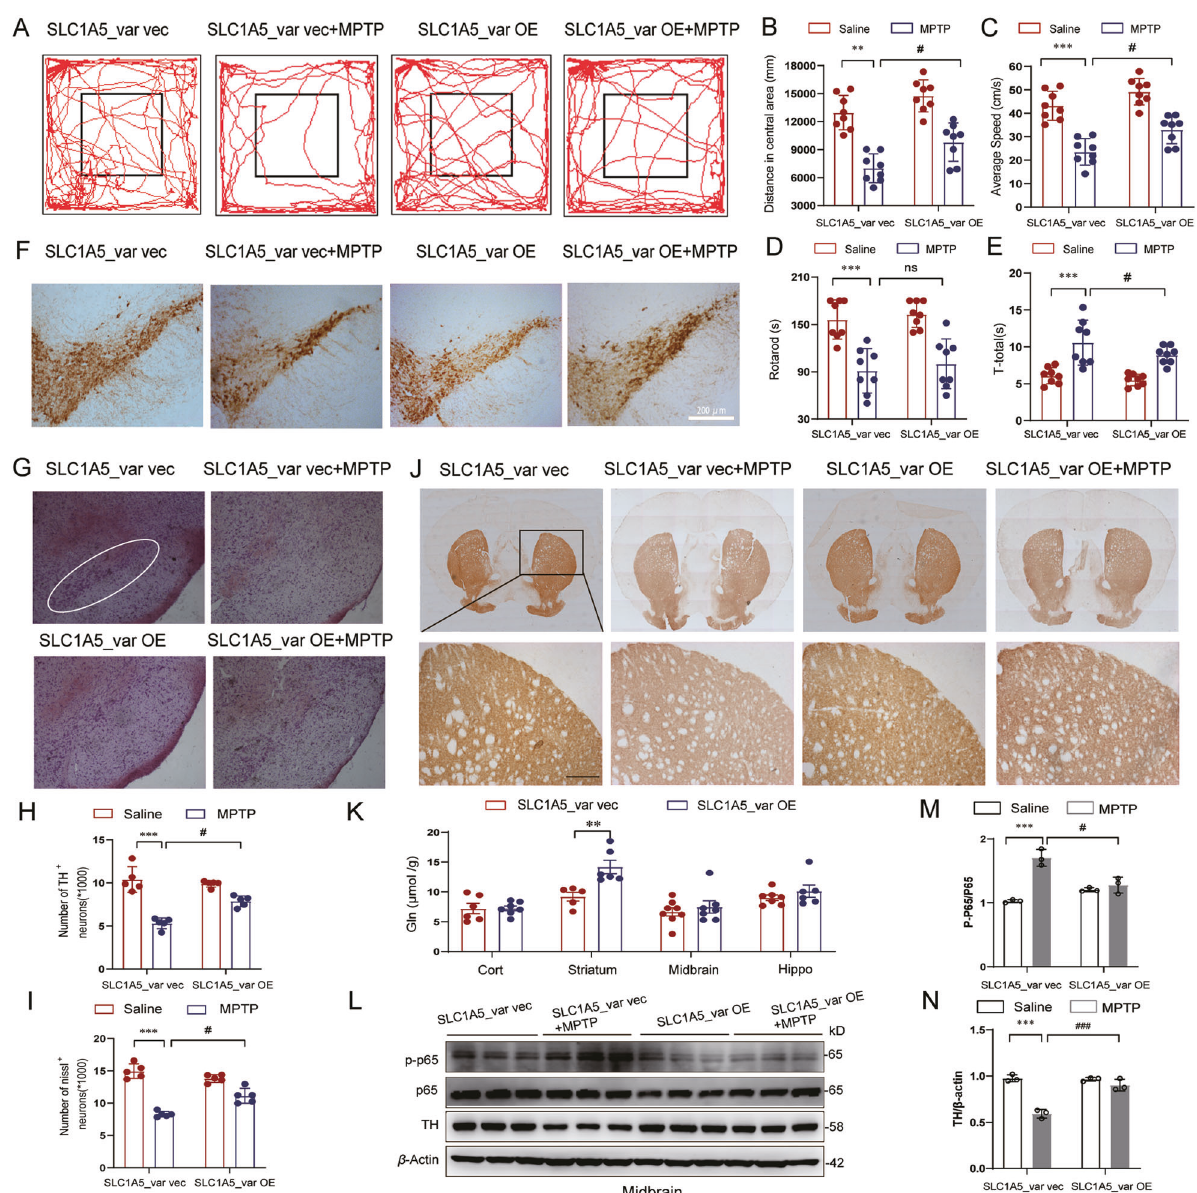
Fig. 8 SLC1A5_var exhibited neuroprotective effects in the MPTP-induced PD mice model. Moving routes ( A ), distance ( B ), and speed ( C ) of mice in the open fi eld in 5 min. D Total climbing time in the pole test. E Latency to fall in the rotarod test within 180 s. A – E ( n = 8 mice/group). Immunohistochemical images of TH + neurons ( F ) and nissl + neurons ( G ) in SNpc with quanti fi cation ( H , I ) ( n = 5 mice/group). Scale bars, 200 μ m. J Immunohistochemical images of TH + neurons in the striatum. Scale bars, 80 μ m. K The content of Gln in different brain regions of mice was analyzed by HPLC ( n = 6 mice/group). Data are shown as the mean ± S.E.M. ** P < 0.01 using the Student ’ s t test. L – N Protein levels of TH, p-p65, and p65 in the midbrain were analyzed by western blot ( L ) and quanti fi ed ( M , N ) ( n = 3). Data are shown as the mean ± S.E.M. ** P < 0.01, *** P < 0.001 vs control, ns, P > 0.05, # P < 0.05, ## P < 0.01 and ### P < 0.001 vs MPT P group, two-way ANOVA followed by Tukey ’ s post hoc